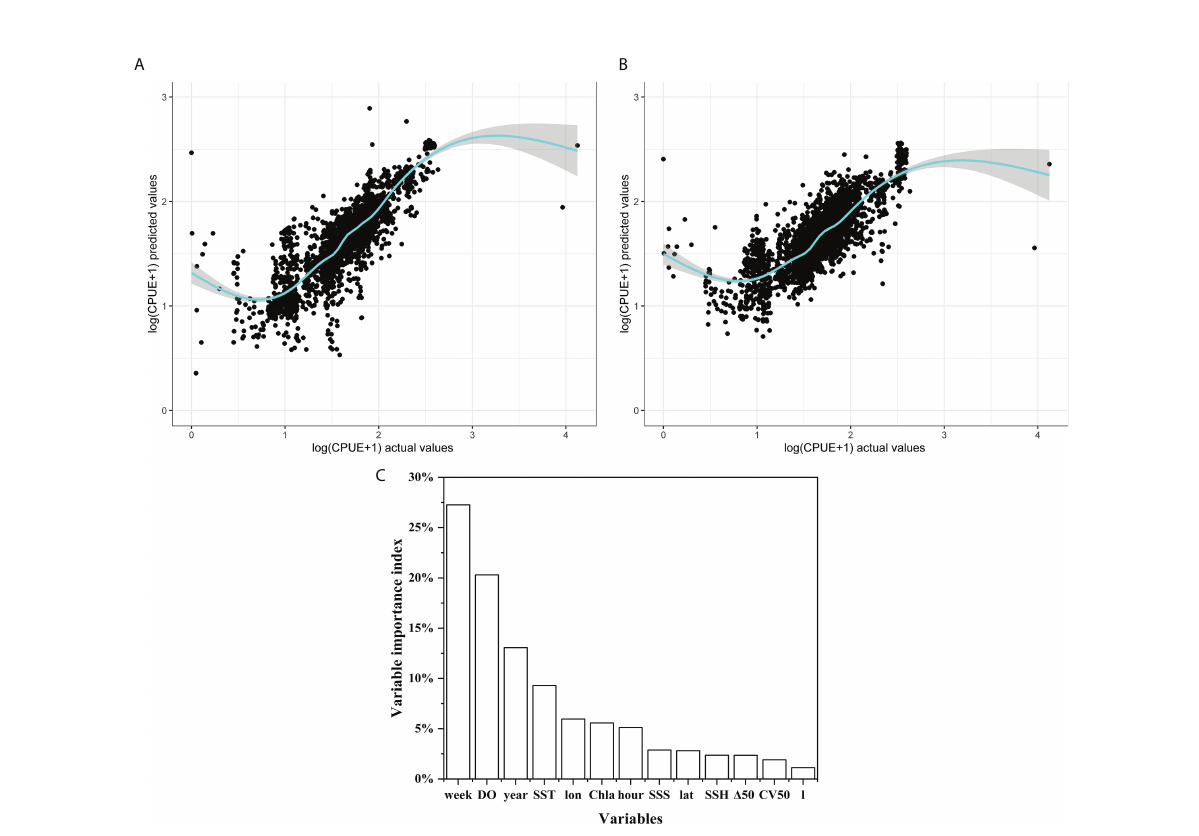
FIGURE 9 Scatter fi tting diagram of RF and GAM models and importance evaluation on variables in RF models. (A) RF model fi t diagram, blue fl uorescence curve is the fi tting curve, the gray area is the con fi dence interval; (B) GAM model fi t diagram, blue fl uorescence curve is the fi t curve, the gray area is the 95% con fi dence interval; (C) Importance ranking of variables for RF